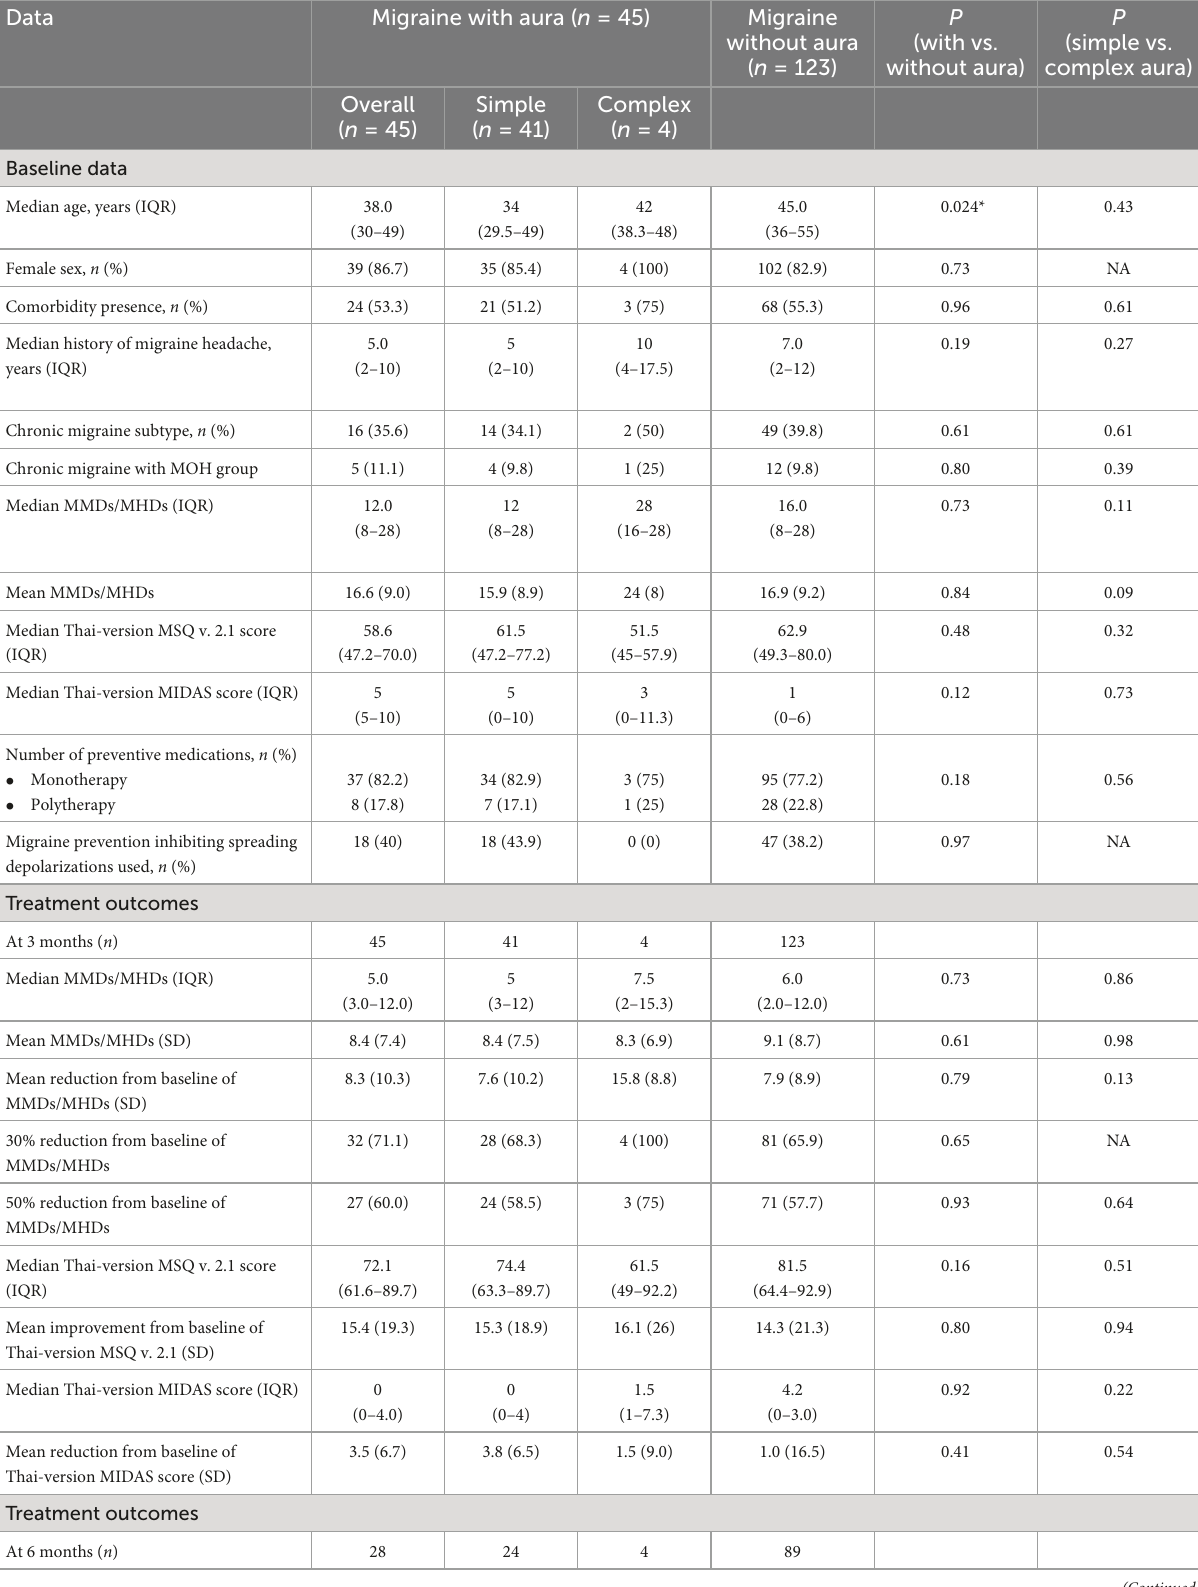
TABLE 2 Baseline age, sex, migraine data, and treatment outcomes for 3 months follow-up for migraine patients with simple or complex aura and without aura. Data Migraine with aura ( n =